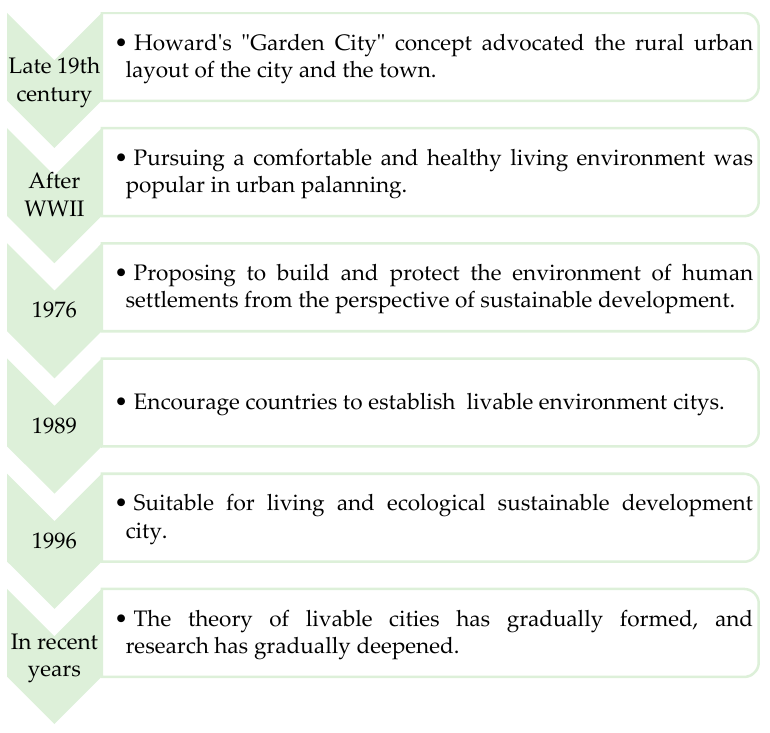
Figure 1. Development of livability in Western Cities.